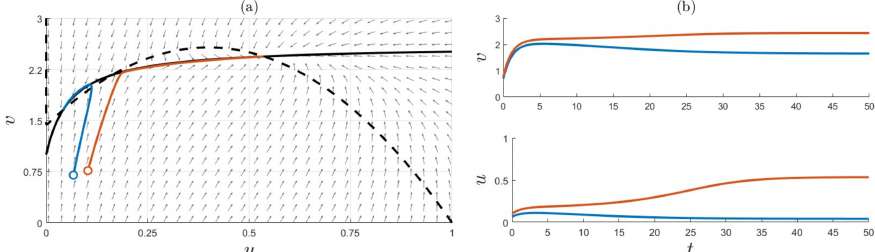
Figure 5. A phase plane and time profiles for u ( t ) and v ( t ) in parameter space which gives rise to the bifurcation diagram shown in Figure 4. In this case, we use parameter values Π 0 = 0.7, a = 0.2, φ = 1, b = 1.6 and c = 0.06. In ( a ), the black solid curve corresponds to the v -nullcline and the black dashed curve to the u -nullcline. The other two coloured curves show solution trajectories in the phase plane. In ( b ), time-dependent solution trajectories are shown and these highlight the bistable nature of the dynamics (using initial conditions that are close together in phase